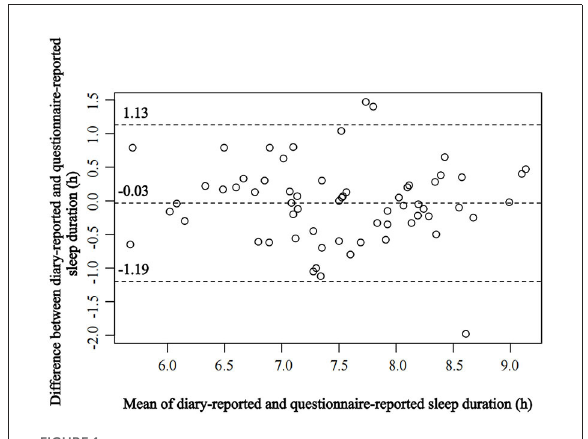
FIGURE1 Bland-Altman plot of diary-reported and questionnaire-reported sleep